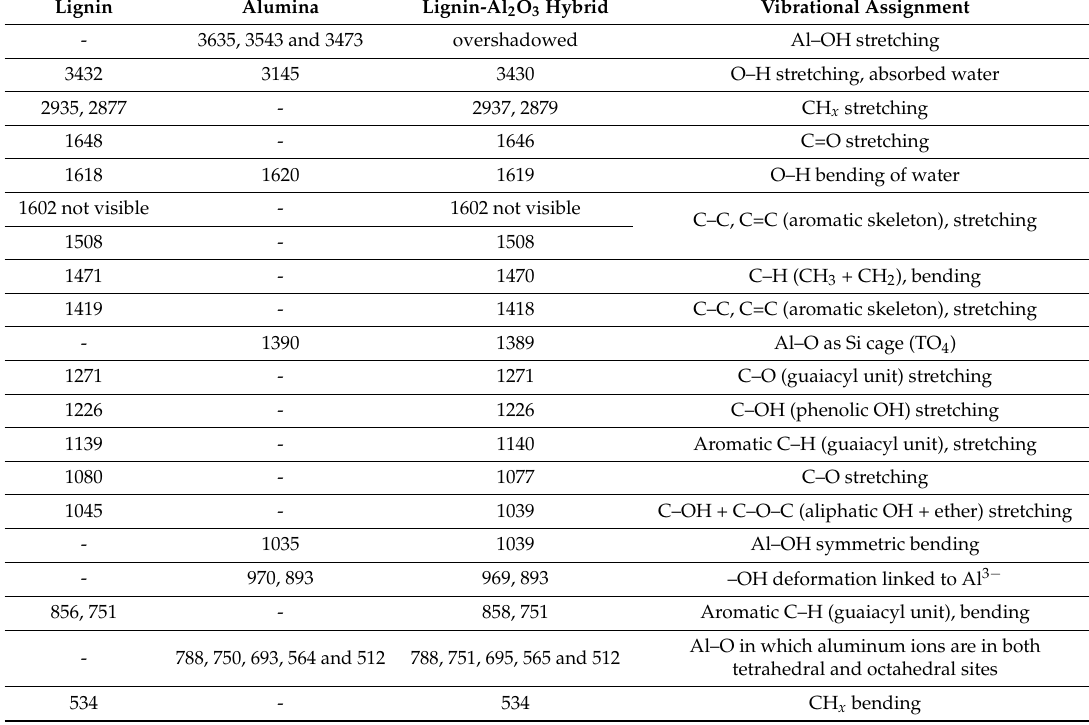
Figure 2. FTIR spectra of pure alumina and lignin ( a ) and of lignin-Al 2 O 3 hybrid fillers ( b ). Table 2. Vibrational frequency wavenumbers (cm − 1 ) for lignin, Al 2 O 3 and lignin-Al 2 O 3 fillers. Lignin